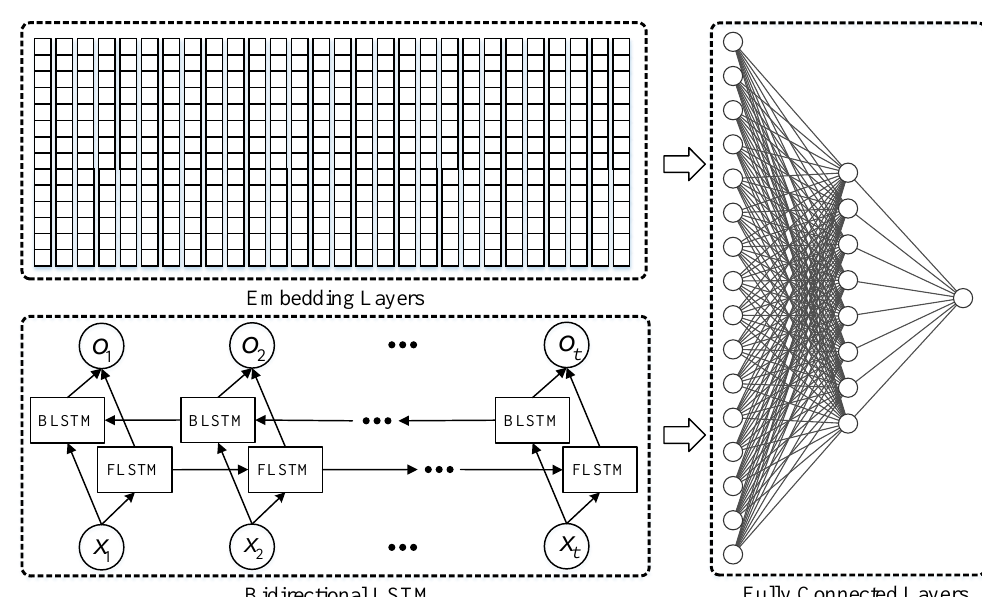
Figure 5. Implementation details of the time series